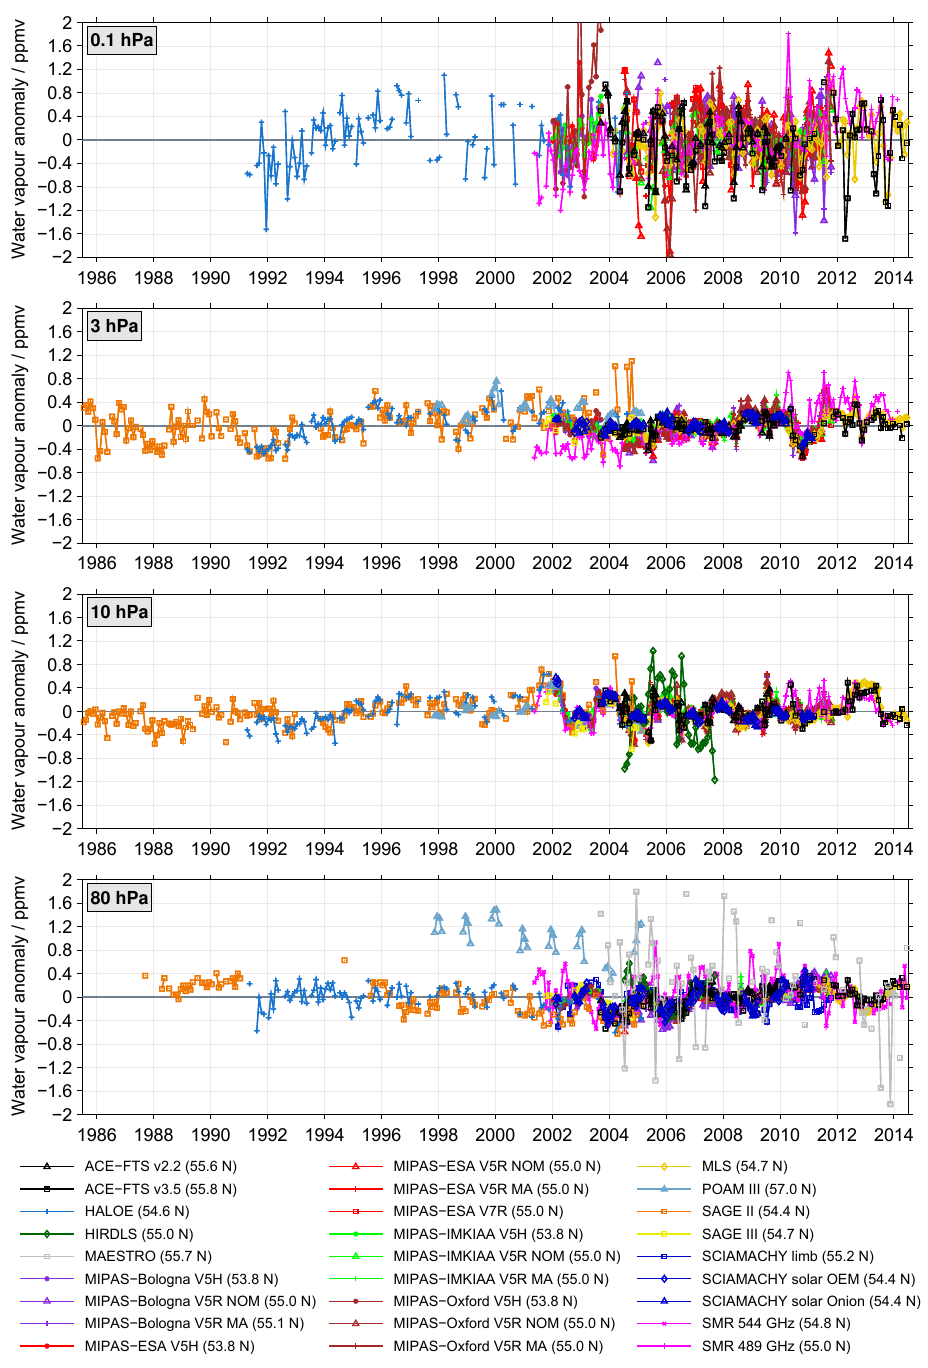
Figure 4. As Figs. 2 and 3, but here the time series for the latitude band between 50 ◦ and 60 ◦ N are shown.